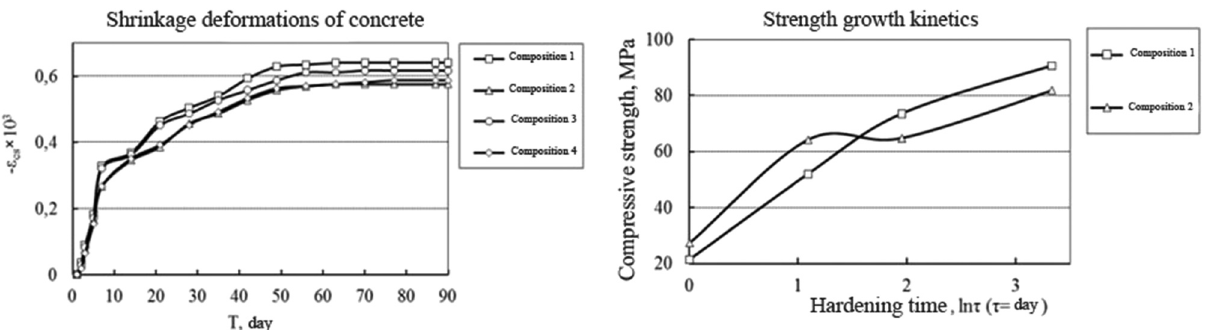
Figure 16: Relative shrinkage deformation of samples of nano - modi fi ed concrete.